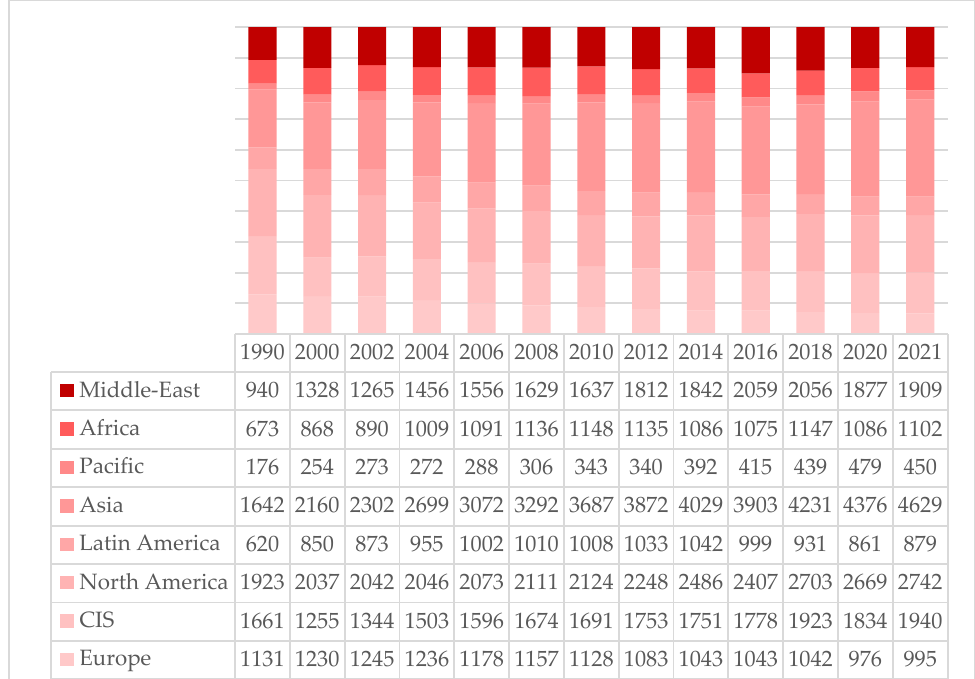
Figure 8. Total energy production by region for 1990; 2000–2020 (when analyzed in a 2 ‐ year period); 2021, Mtoe [29].